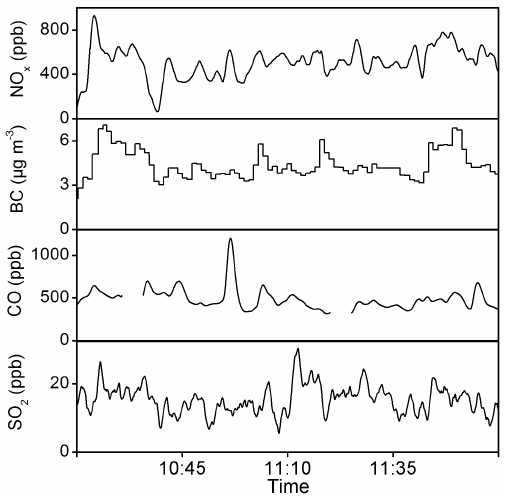
Figure 4. The time series of the concentrations of NO x , CO, SO 2 and BC measured on 13 June.